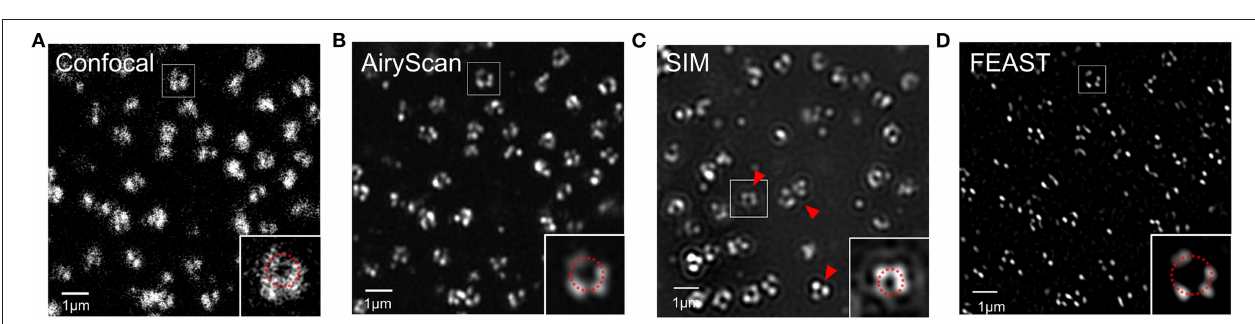
FIGURE 3 | Comparison of the results of F-actin in Hela and NPC in U2OS before and after expansion (A) F-actin stained with benzoylguanine (BG)-dsDNA-Alexa488 before expansion. (B) Enlargement of part of picture (A) . (C) F-actin stained with BG-dsDNA-Alexa488 after expansion. (D) Enlargement of part of picture (C) . (E) Intensity distribution plot along arrows in (B,D) . (F) nNup153 stained with BG-dsDNA-Alexa488 before expansion. (G) Zoomed in view of (F) . (H) nNup153 stained with BG-dsDNA-Alexa488 after expansion. (I) Zoomed in views of (H) . (J) Line profiles of selected nuclear pore complexes in (G,I) . Scale bar: 5 µ m in (A,C) , 1 µ m in (F,H) .